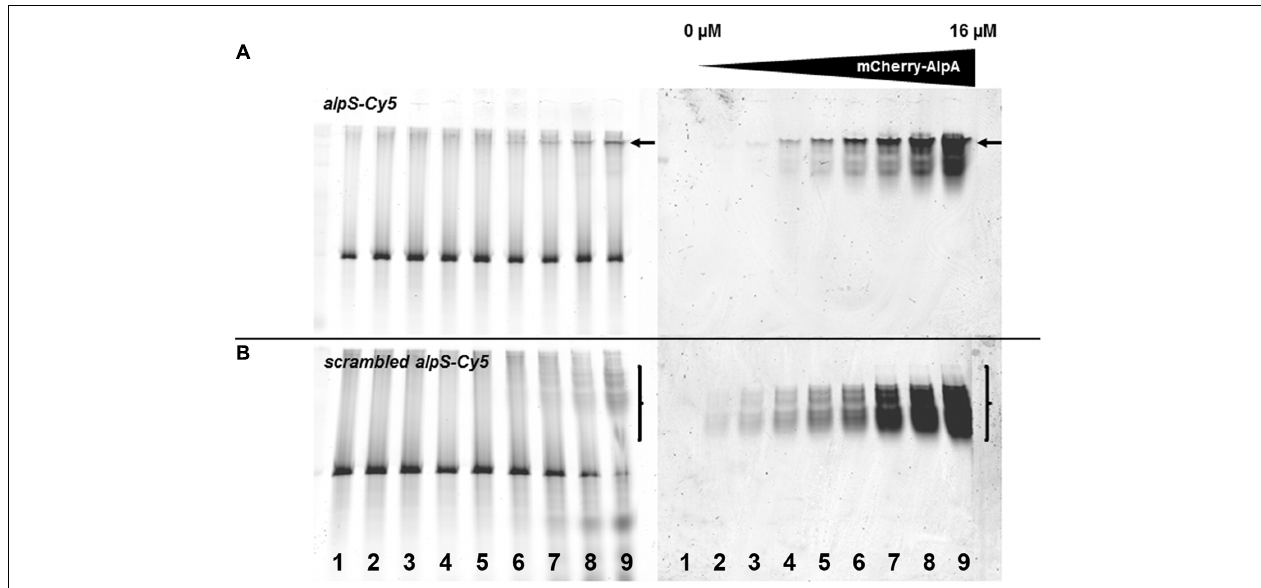
FIGURE 3 | mCherry-AlpA binds to alpS DNA in vitro . EMSA with purified mCherry-AlpA binding alpS -Cy5 consensus sequence (A) and a scrambled alpS sequence (B) . Increasing concentrations of mCherry-AlpA were used [lane 1: 0 µ M (DNA only), lane 2: 0.125 µ M, lane 3: 0.25 µ M, lane 4: 0.5 µ M, lane 5: 1 µ M, lane 6: 2 µ M, lane 7: 4 µ M, lane 8: 8 µ M, lane 9: 16 µ M) to shift 500 ng double stranded DNA. Loading was identical for (A) and (B) . Note the different behavior of binding. mCherry-AlpA shifts alpS -Cy5 to a sharp, highly defined band (arrow), while binding to scrambled alpS sequences results in a smear of lower shifted bands